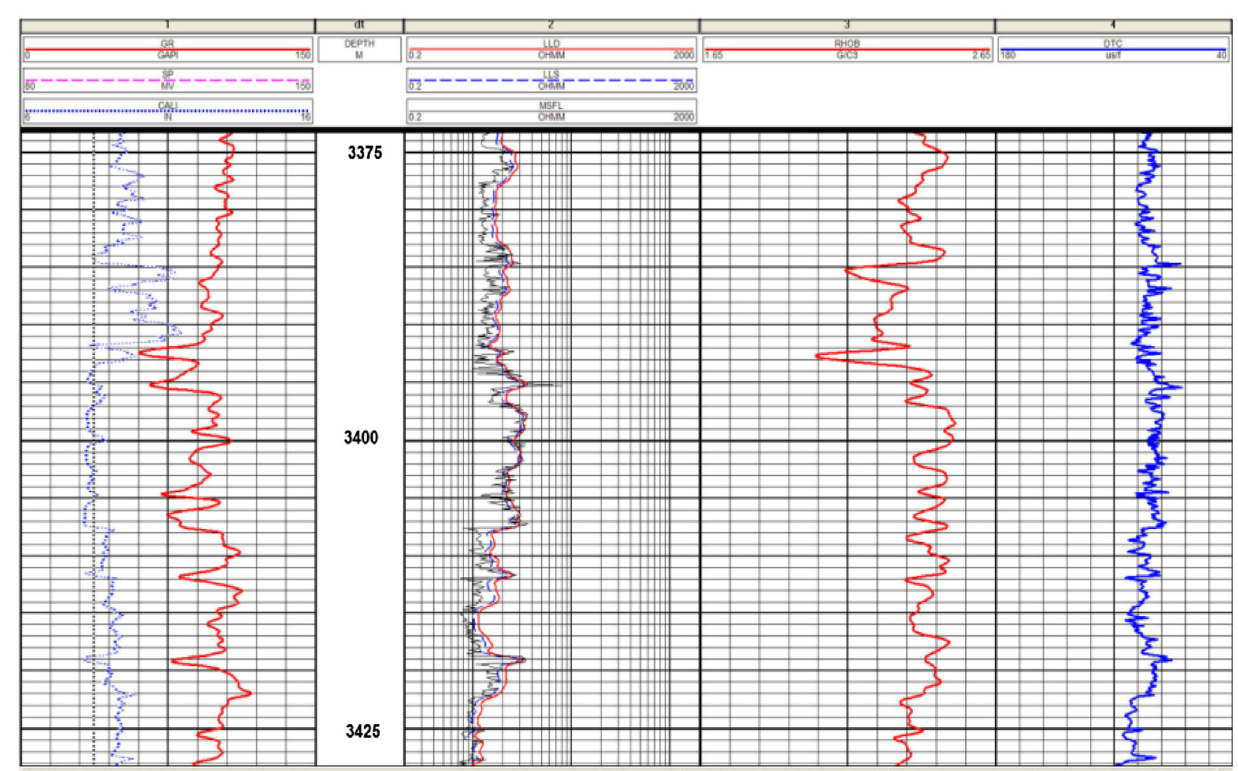
Fig. 4 Measured density curve on track-3 ( red ) for well- A requires